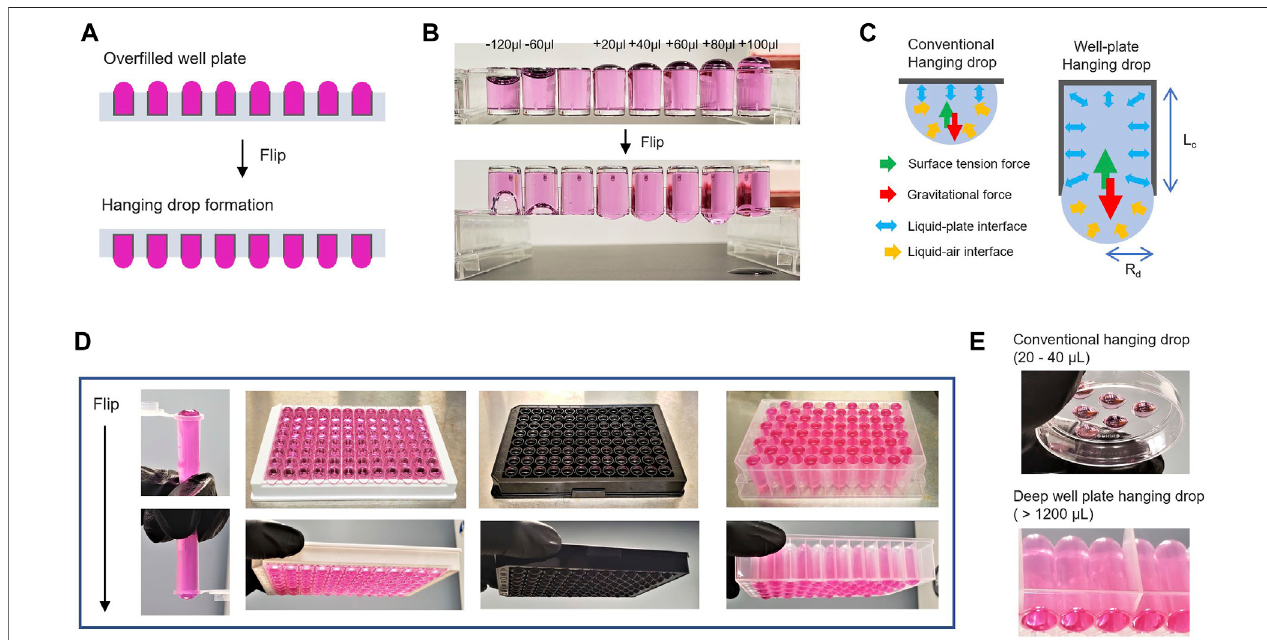
FIGURE 1 | Hanging drop formation by well-plate fl ip. (A) . Schematic illustration of an over fi lled and fl ipped well-plate to generate hanging drop meniscus. (B) . Images of 96-well-based strips to compare under fi lled wells ( − 120 and − 60 μ l) and over fi lled wells (20 – 100 μ l) to the maximum volume of a well before/after fl ipping the plate. (C) . Comparison of conventional hanging drop and well-plated hanging drop formation. The mechanistic rationale of hanging drop formation generated at the bottomofa fl ippedwell-plate.R d istheradiusofthependantdrops,andL c isthecapillarylengthofthewell-plate. (D) Representativeimagesofthe fl ippedtubeand well-plate over fi lled with 60 μ l from the maximum volume of each designed dimension (from left to right: 0.7 ml microcentrifuge tubes, Elisa 96-well strip, Black 96-well plate, and 1.1 ml Deep 96-well plate). (E) Images of conventional hanging drop in the lid of a plastic plate and deep well-plate hanging